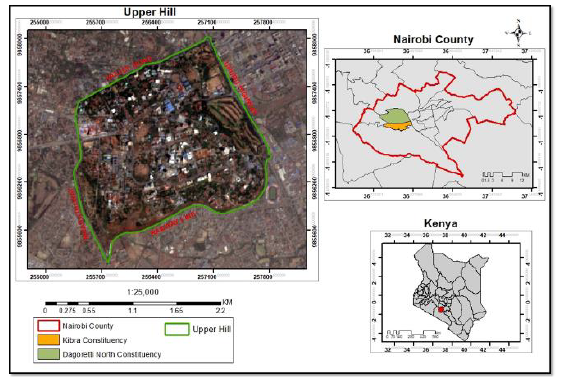
Figure 1: Location of Upper Hill in Nairobi